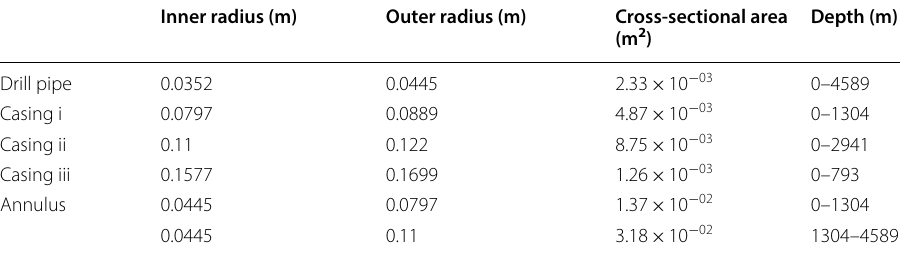
Table 3 Geometrical extensions of the